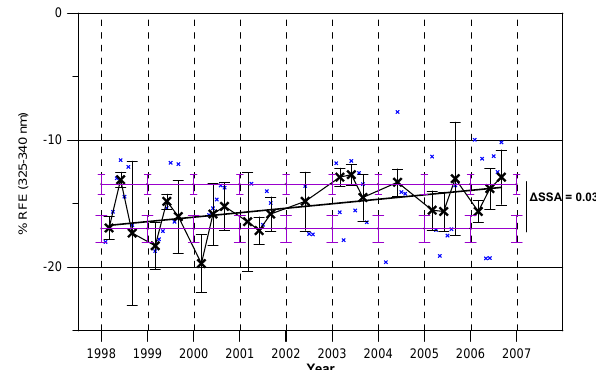
Figure 3. Seasonal (blue symbols) and monthly (black line) AODs changes for Fig. 3. Seasonal (blue symbols) and monthly (black line) AOD slant Thessaloniki, Greece. changes for Thessaloniki, Greece.